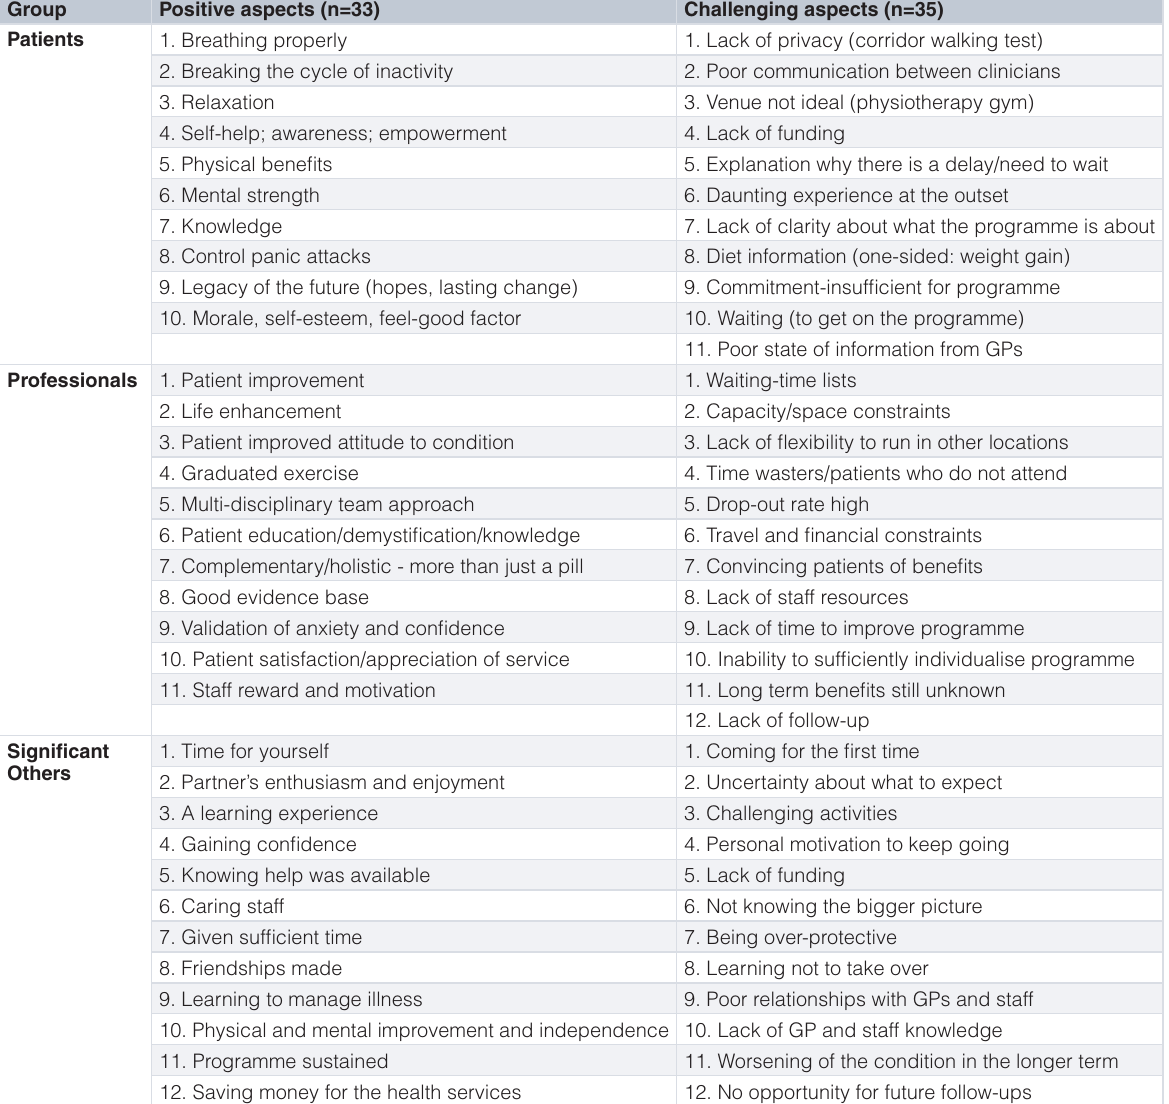
Table 2. Positive and challenging aspects generated by each of the study workshops.